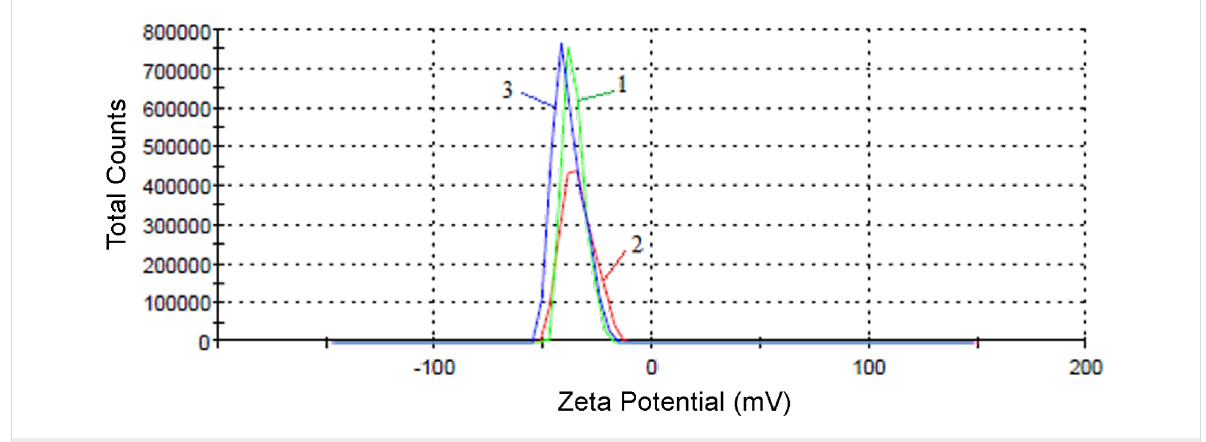
Figure 7: Evaluation of the cholesterol-containing biohybrid (sample V4) stability from the zeta potential distribution, where the ZP was performed in triplicate and the indices 1, 2 and 3 refer to each measurement.